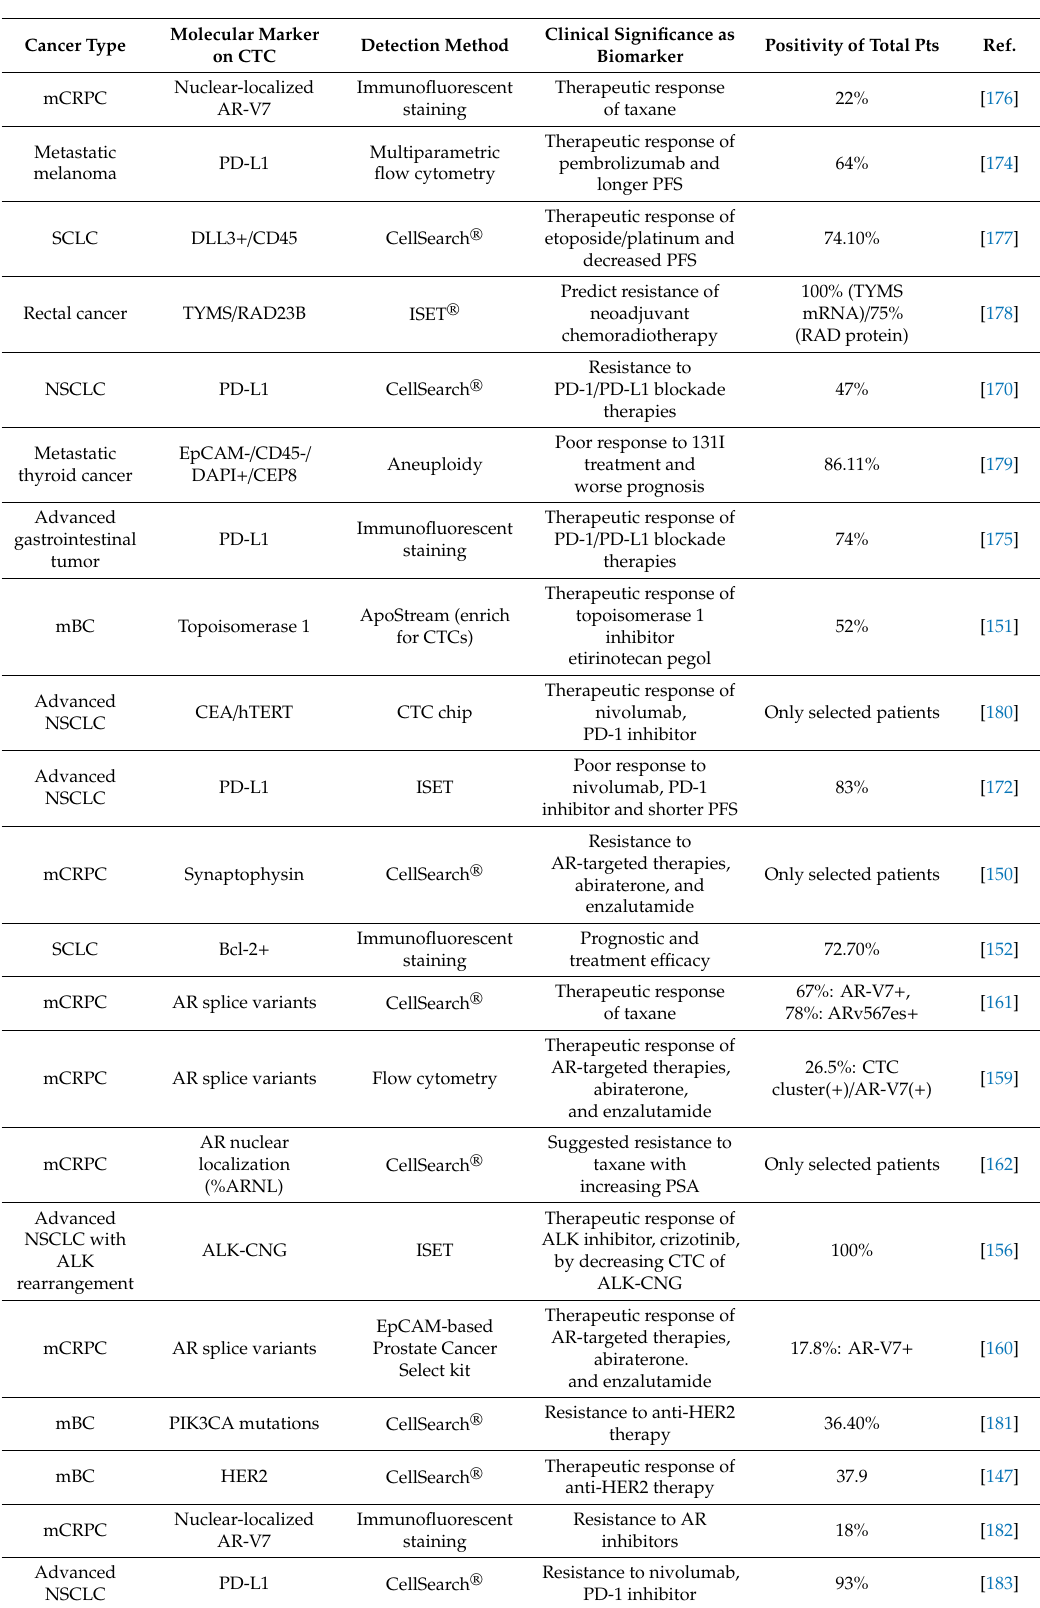
Table 3. The potential treatment response markers expressed on CTCs for future precision medicine. Cancer